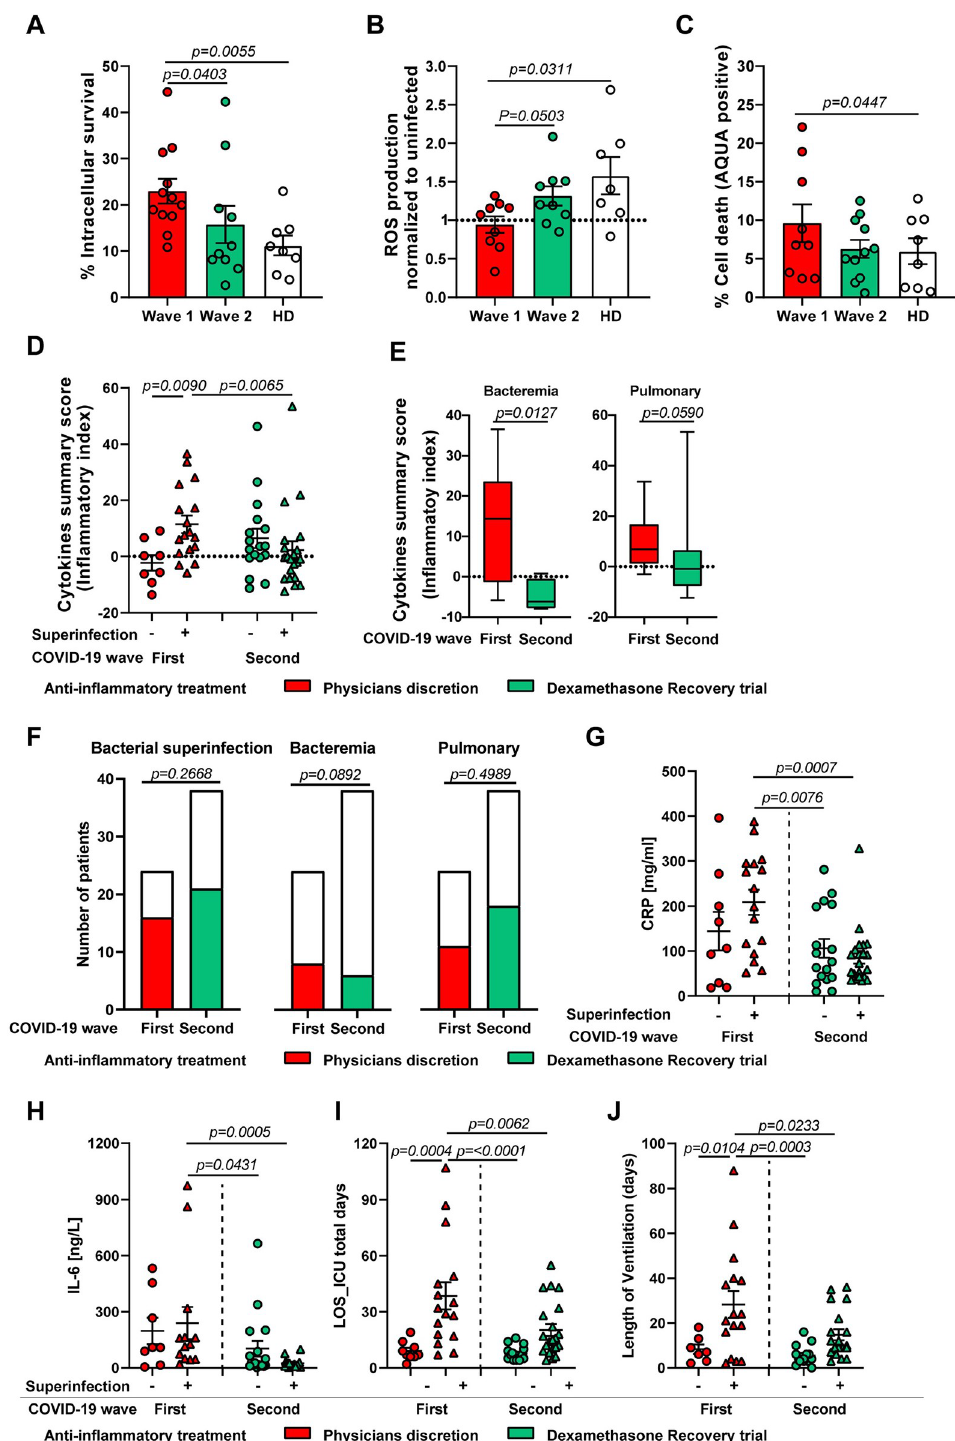
Fig 9. Quantification of inflammatory mediators in plasma and its association with bacterial superinfection compared between the first and second COVID-19 wave. ( A-C ) Intracellular bacterial survival ( A ), ROS production ( B ) and cell death ( C ) of healthy donor neutrophils (n = 6) pre-exposed to either 10% of wave 1 acute-phase (n = 9–12), wave 2 acute-phase (n = 8–10) or healthy donor plasma (n = 7–8) for 3 h and subsequently infected with SA at MOI 10 ( A ) or 1 ( B and C ). ( D and E ). Normalized cytokine values (sum of Z-scores) depicted as cytokine summary